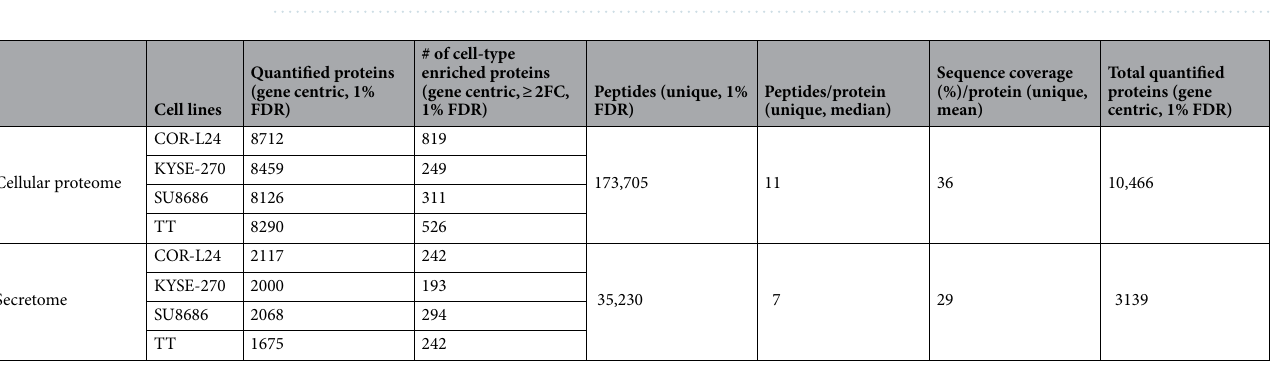
Table 1. Protein quantification in 4 cell lines. Summary of the number of quantified proteins from biological triplicate analysis of each cell line in cellular proteome or secretome.